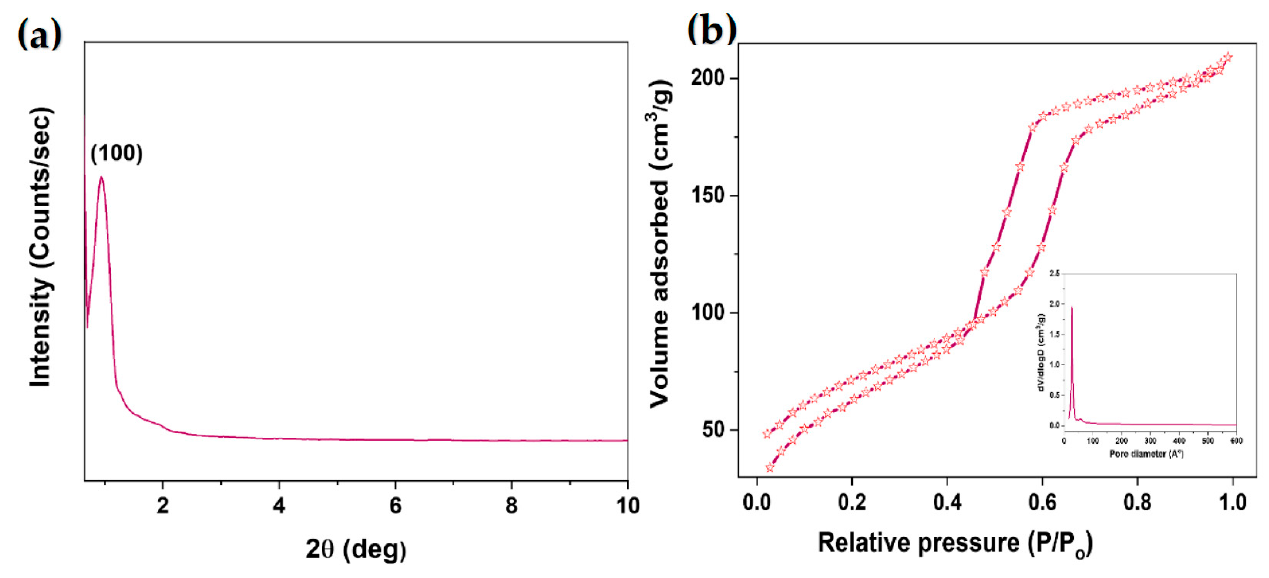
Figure 2. Structural and surface area analysis. ( a ) Low-angle XRD pattern of the MSH@MA NPs. ( b ) N 2 adsorption–desorption isotherm and pore size distribution (inset figure) of the MSH@MA